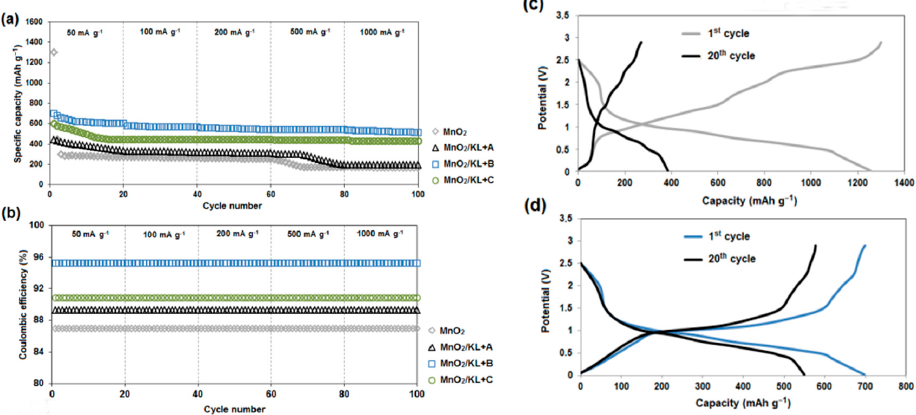
Figure 16. Rate capability of the systems ( a ); coulombic efficiency ( b ); charge/discharge curve of pure MnO 2 ( c ) and charge/discharge curve of MnO 2 /KL+B ( d ). Table 7. Example of a functional anode materials.